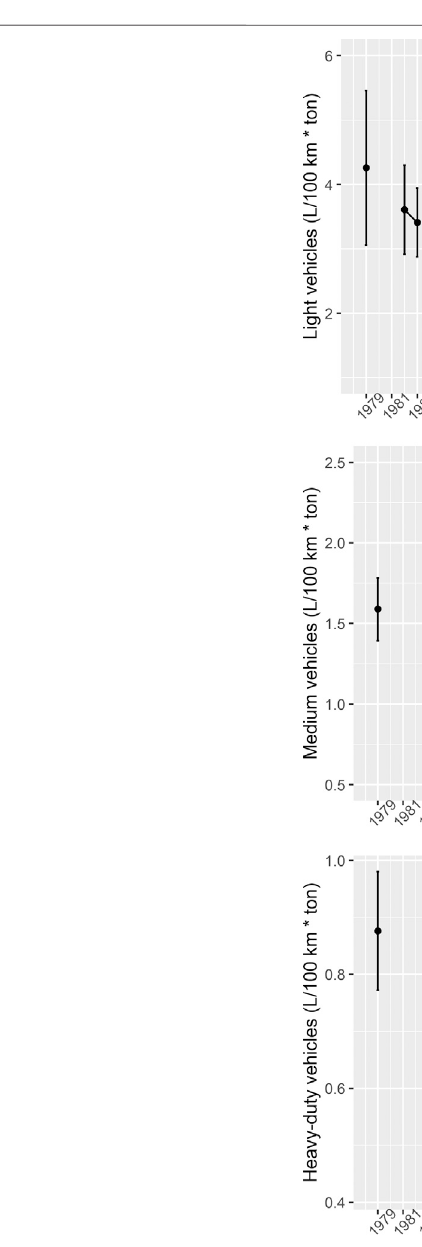
FIGURE 2 | Trend in fuel intensities (L/100 km*t; 1978 – 2018) for light, medium and heavy duty